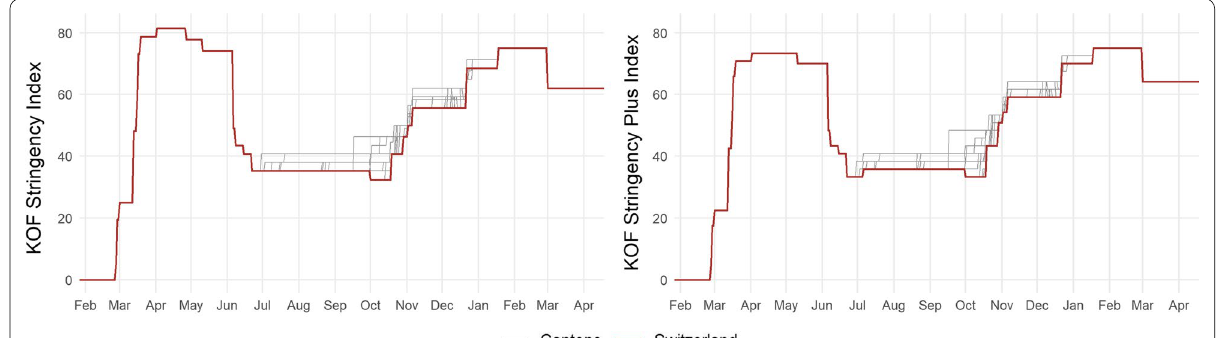
Fig. 2 KOF stringency indices for Swiss cantons. The graph depicts the KOF Stringency Index (left) and the KOF Stringency‑Plus Index (right). The respective index is denoted on the y ‑axis. Note that cantonal variation only starts at the end of June. The first lockdown was governed by federal measures